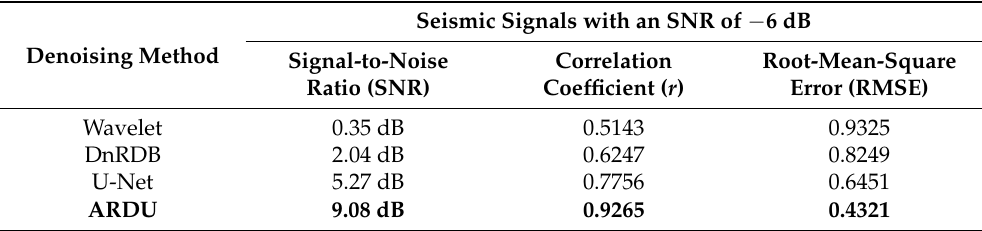
Table 1. Denoising results of seismic signals with an SNR of − 6 dB using different methods.